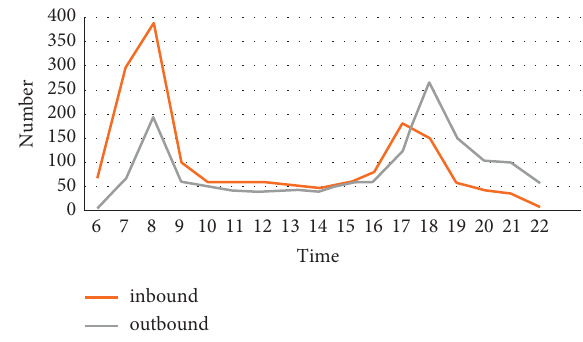
Figure 8: Passenger flow statistics of the subway station in the residential